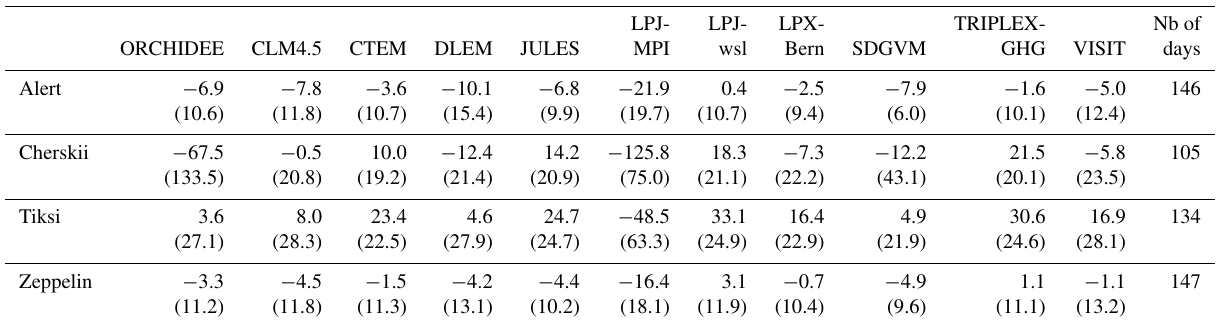
Table 7. Mean difference (and standard deviation) between observed and simulated CH 4 (in ppb) calculated on a daily basis between June and October at four continuous measurement sites, for 11 land-surface